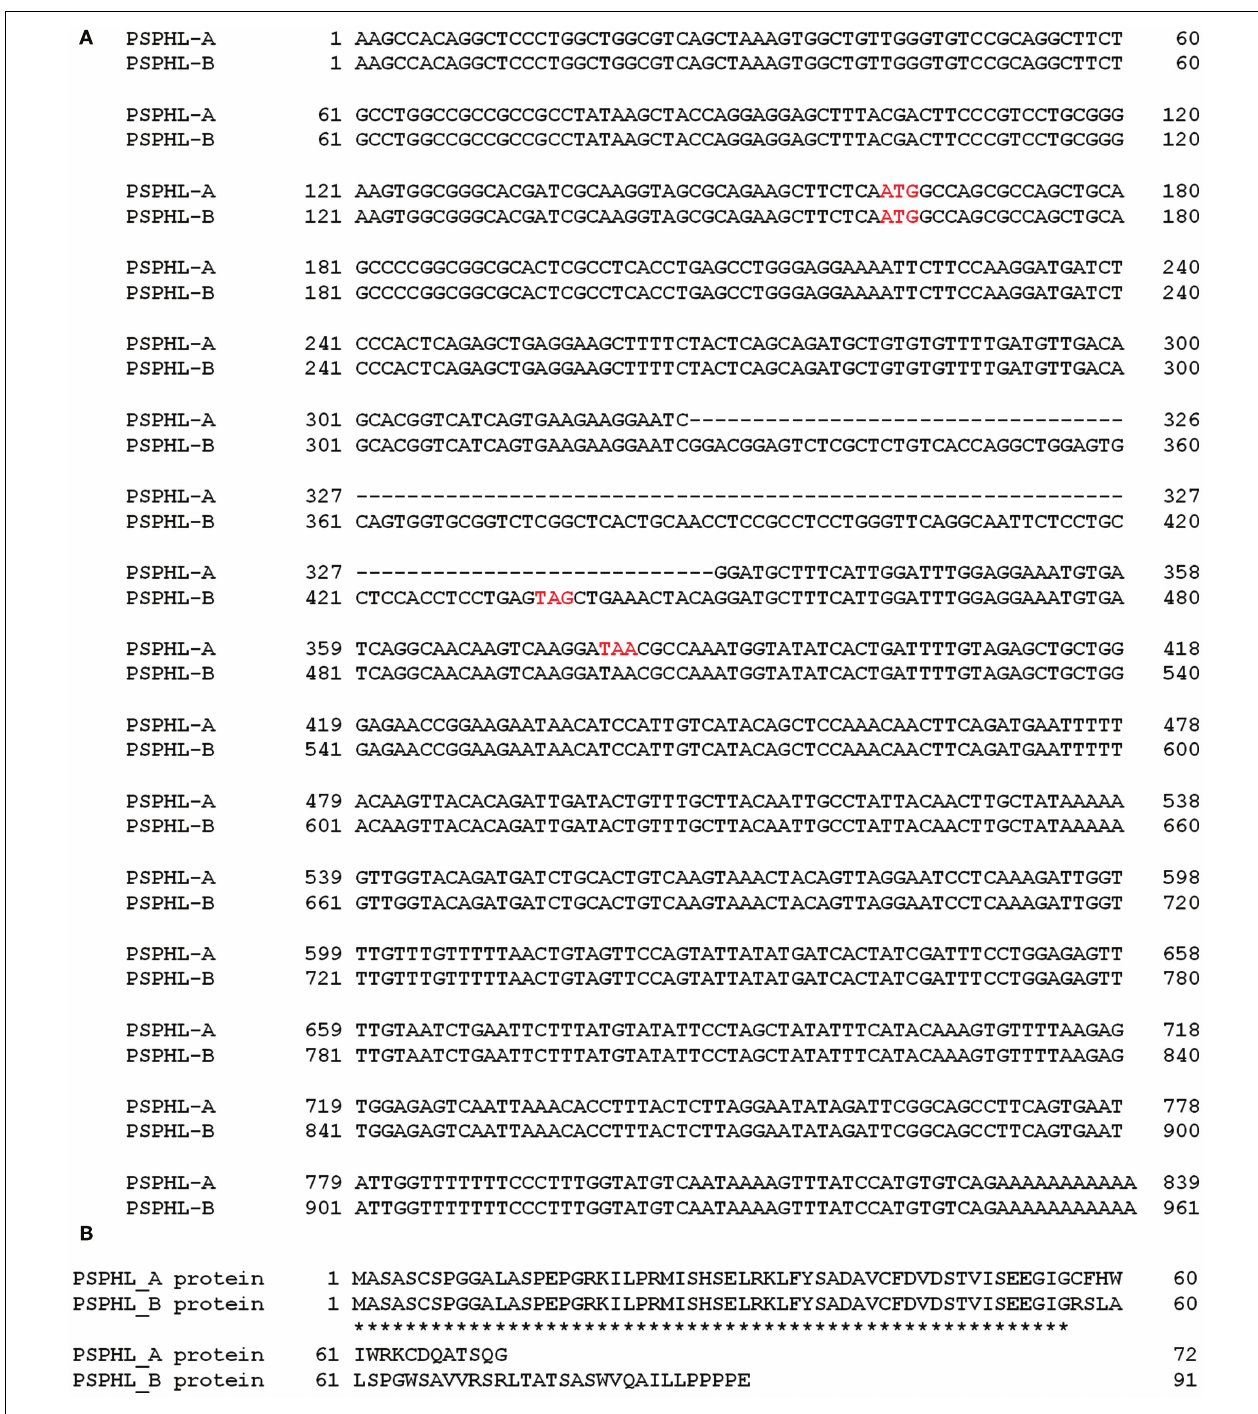
(B) Protein homology of splicing variants of PSPHL PSPHL_B has a novel spliced 122bp sequence in the middle of PSPHL_A form alters the reading frame and utilizes a different stop